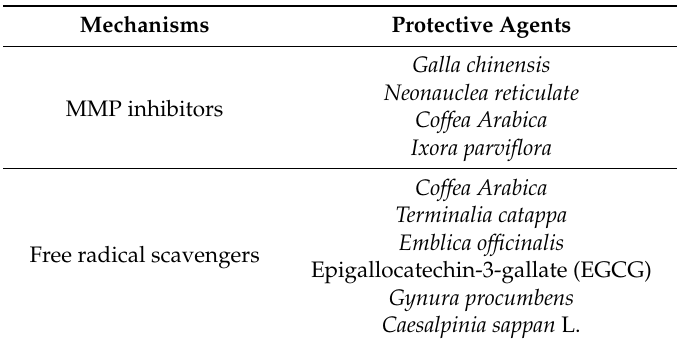
Table 3. Protective agents against